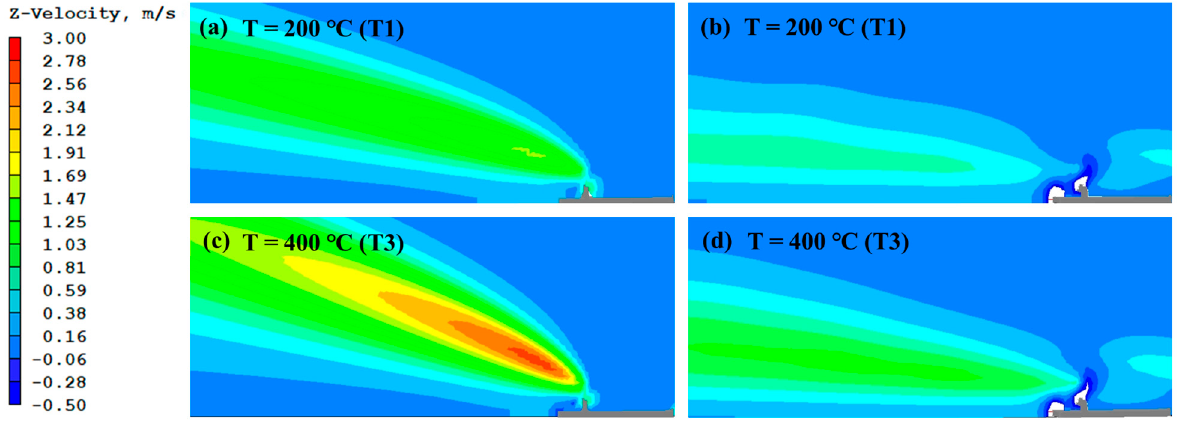
Figure 13. The vertical velocity contours in the S4 − V2 scenario with a wind speed of 3 m/s: ( a ) sta- tionary source of T1; ( b ) moving source of T1; ( c ) stationary source of T3; and ( d ) moving source of T3.